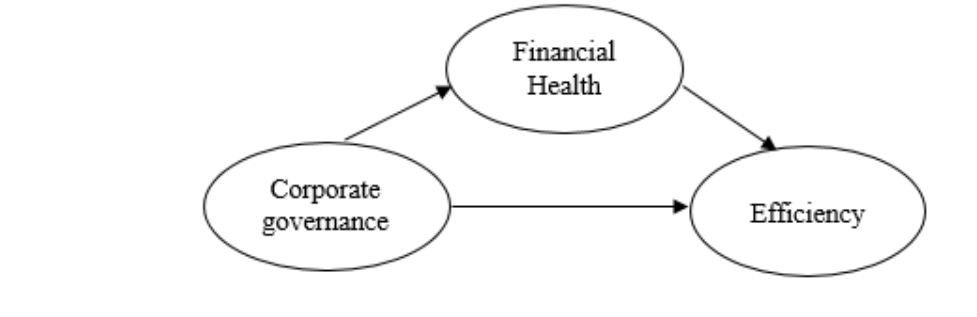
Figure 1. Conceptual model of